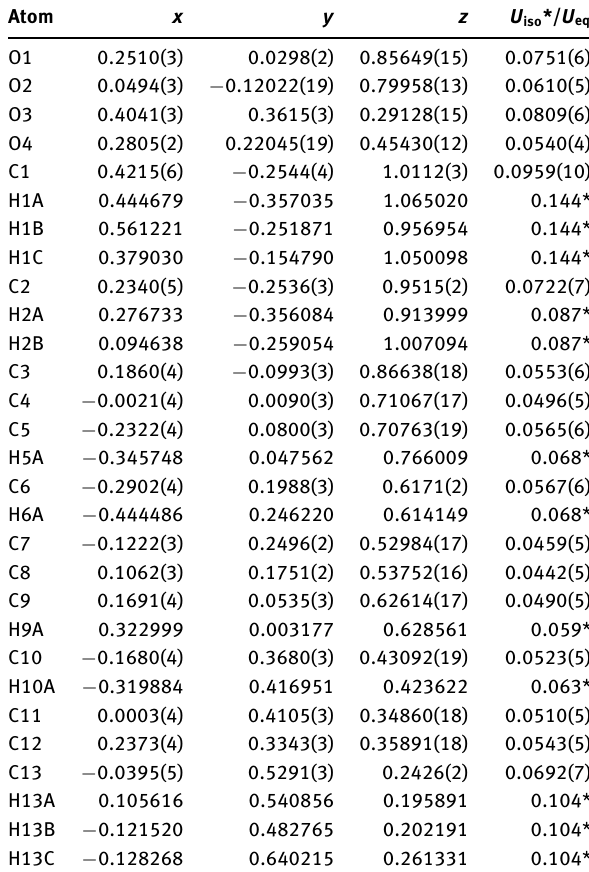
Table 2: Fractional atomic coordinates and isotropic or equivalent isotropic displacement parameters (Å 2